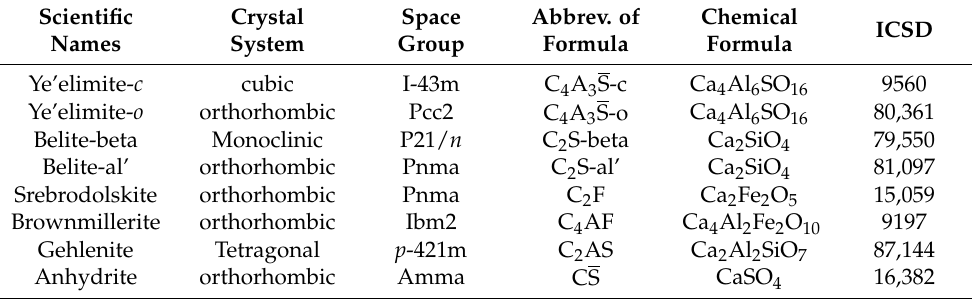
Table 2. Crystallographic structures and ICSD codes of phases involved in the Rietveld refinement.